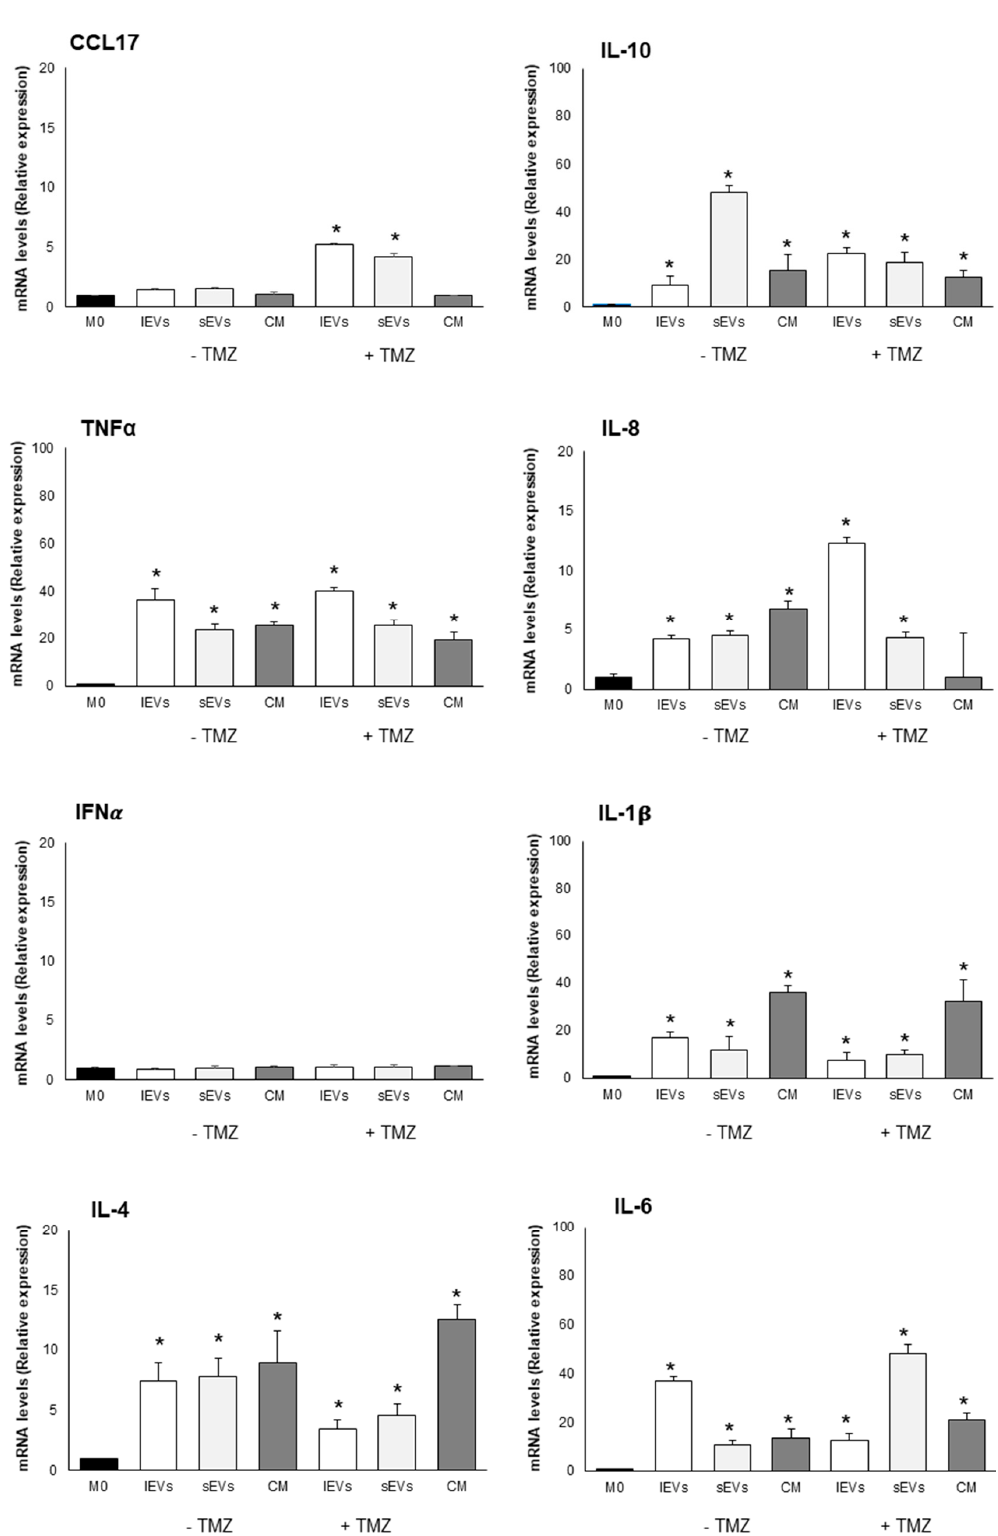
Figure 5. Macrophage polarization markers after exposure to 200 µM temozolomide (TMZ) for 48 h treated or non TMZ- treated U-87 MG cells derived lEVs, sEVs and free EVs CM for 24 h. The mRNA levels of CCL17, IL-10, TNF α , IL-8, IFN α , IL-1 β , IL-4, and IL-6 are normalized to GAPDH mRNA level and expressed as a relative expression with respect to M0. The values for all experimental groups reported in the histograms represent the means ± SD (n = 3) of three independent experiments; (*) p < 0.05 compared to the control M0.